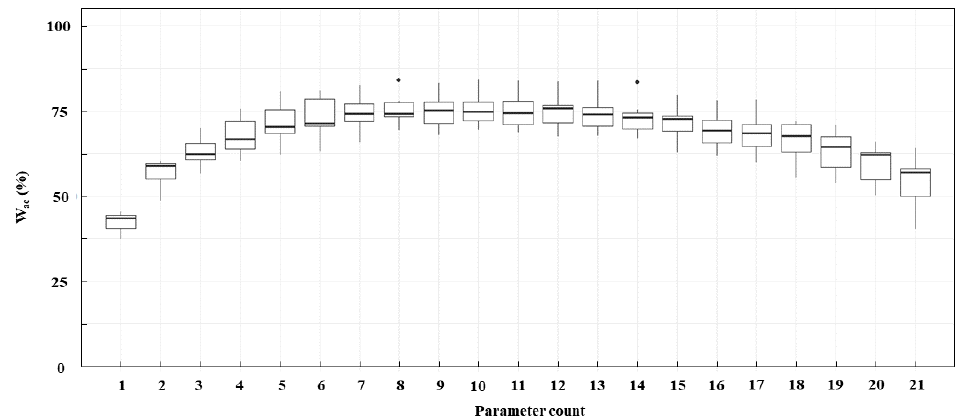
Figure 8. Boxplot of overall weighted accuracy achieved by all classification models using different number of structural parameters. The bold line means the median value of all weighted accuracy achieved by the corresponding number of parameters. The individual black points are the outliers of all weighted accuracy. The bottom line and top line of the box are the median of lower half and upper half of all weighted accuracy achieved by the corresponding number of parameters.